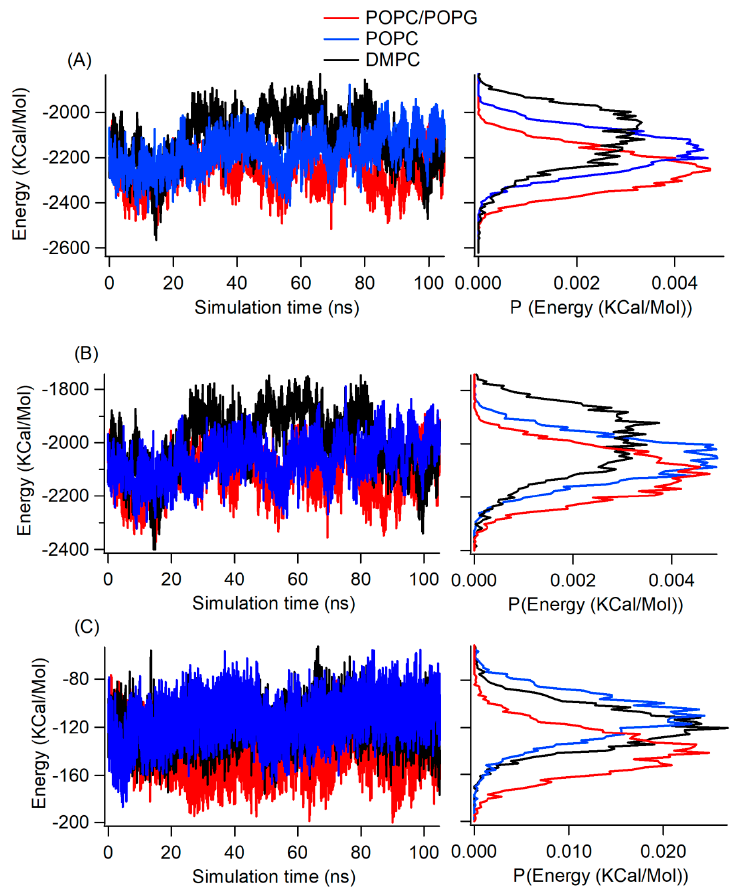
Figure 7. Internal energy of KCNE3 in lipid bilayer membranes as a function of simulation time (left panel) and corresponding histogram (right panel) for total internal energy ( A ), electrostatic energy ( B ) and van der Waals energy ( C ). The x ‐ axis of the histogram plot represents the probability distribution.